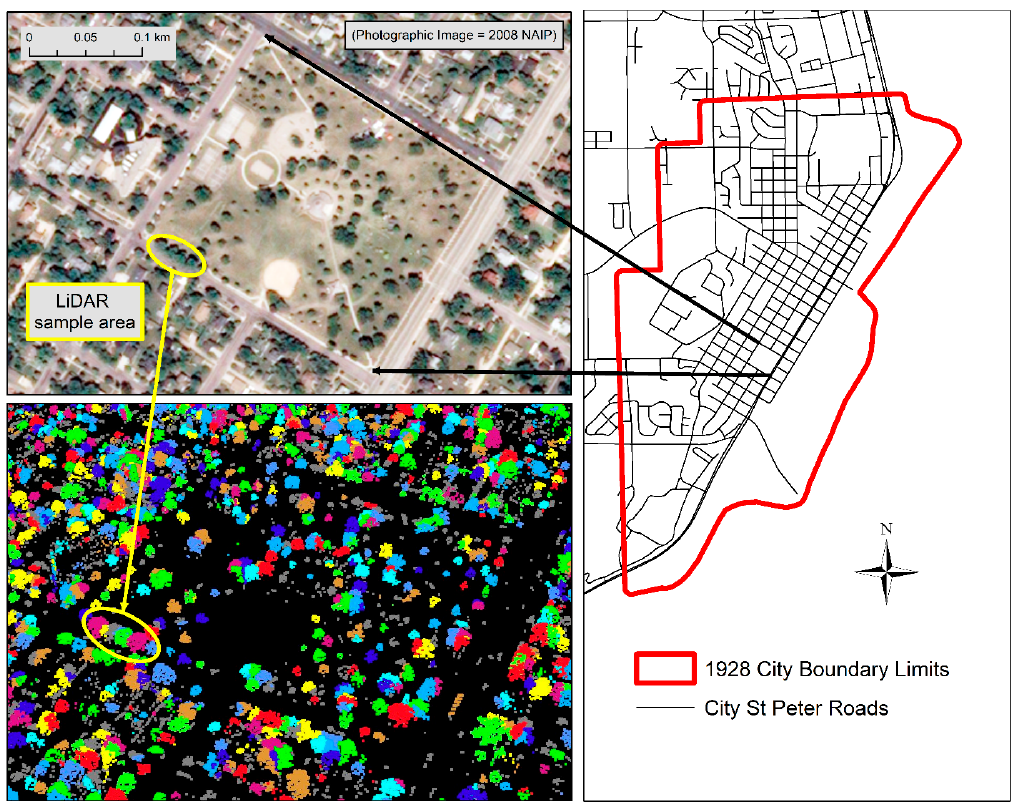
Figure 8. Location of sample LiDAR results.